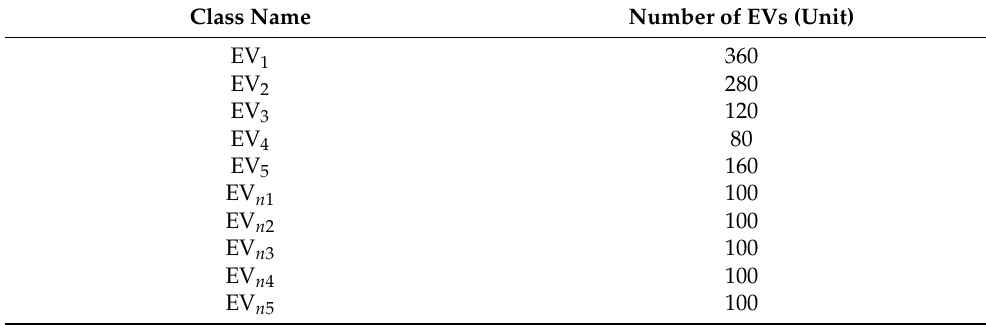
Table 3. Number of EVs in each charging class (when mitigation conditions were changed).